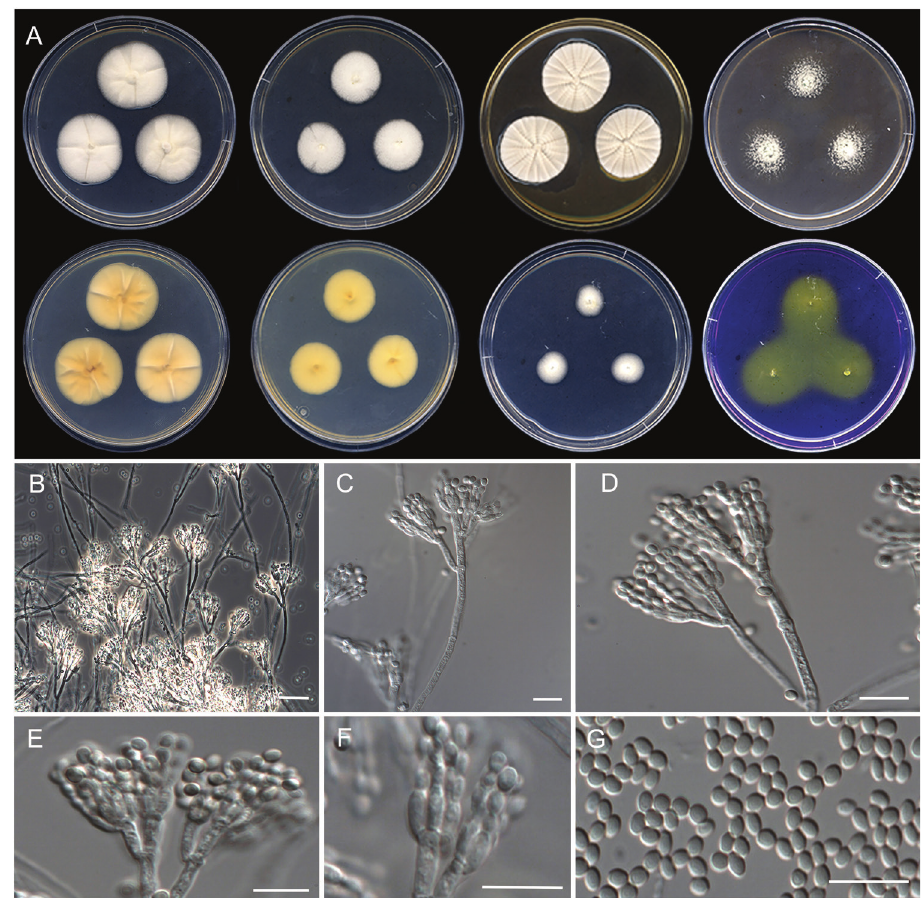
Figure 14. Morphological characters of Penicillium submersum sp. nov. (ex-type FMR 17140). A colo- nies from left to right (top row) CYA, MEA, YES, and OA; (bottom row) CYA reverse, MEA reverse, DG18, and CREA B–F conidiophores on MEA G conidia. Scale Bars: 25 μm ( B ), 10 μm ( C–G